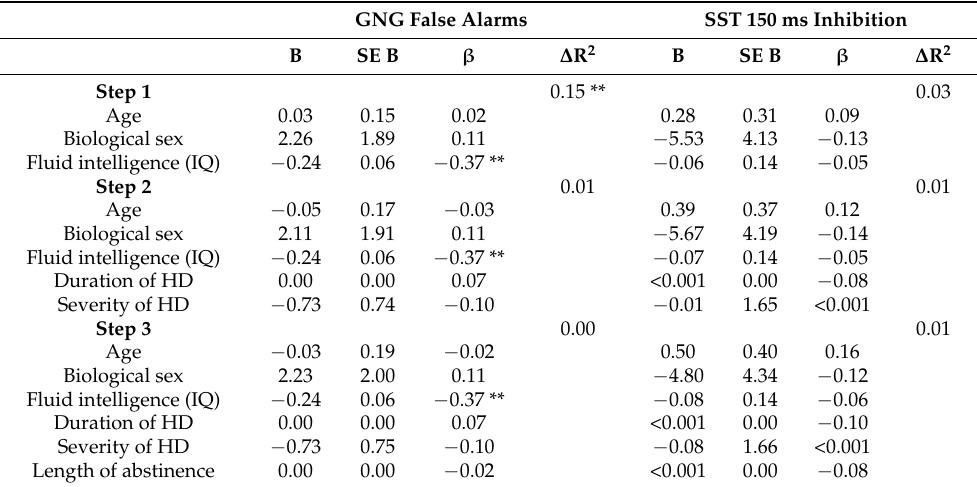
Table 5. Length of abstinence as predictor of GNG False Alarms and SST 150 ms